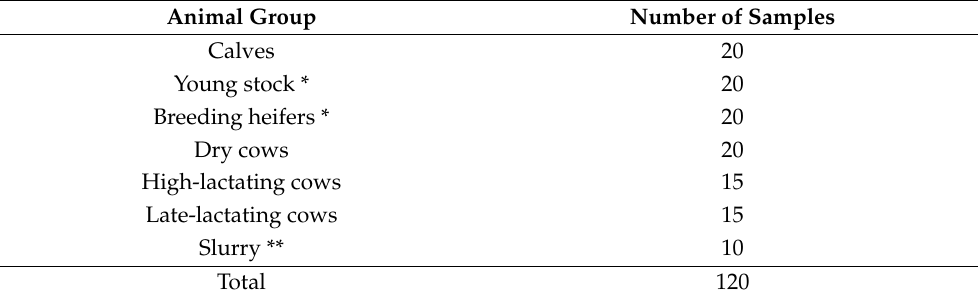
Table 3. Sample numbers for each animal group and slurry. Animal Group Number of Samples Calves 20 Young stock * 20 Breeding heifers * 20 Dry cows 20 High-lactating cows 15 Late-lactating